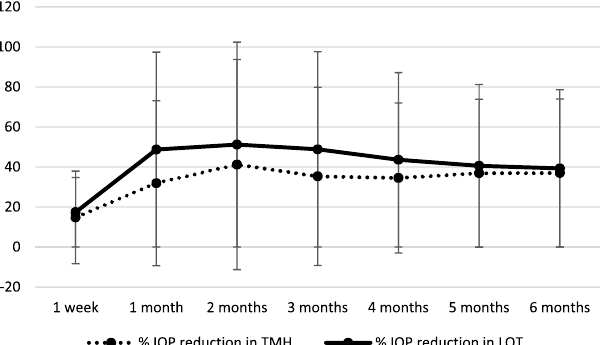
Figure 2. Transition and comparison of rate of IOP reduction. IOP: intraocular pressure. Calculated using linear mixed model between TMH and LOT.